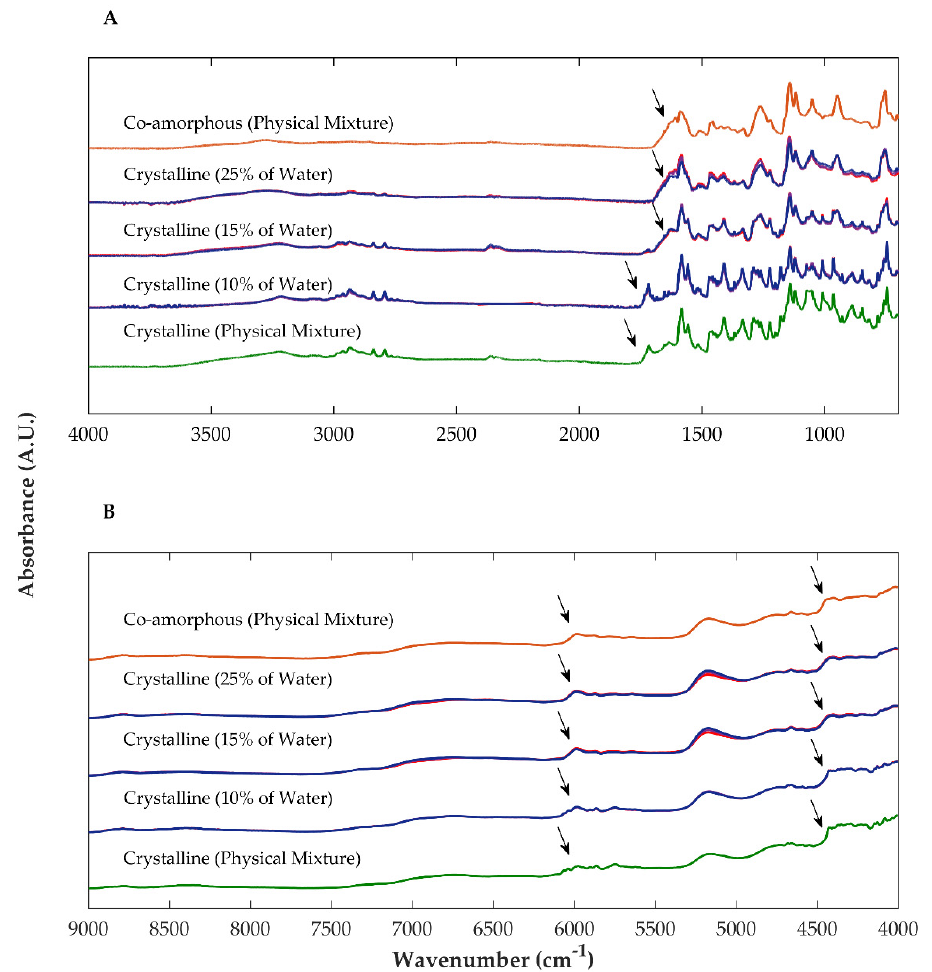
Figure 7. Fourier-transformed mid ( A ) and near ( B ) infrared spectra of formulations containing crystalline olanzapine and saccharin as physical mixtures (green) and after granulation with different fractions of water (10, 15 and 25%). For comparison purposes, the spectra of co-amorphous olanzapine and saccharin in a physical mixture (orange) were plotted. Drying temperature—40 ◦ C (dark blue), 65 ◦ C (purple) and 90 ◦ C (red).